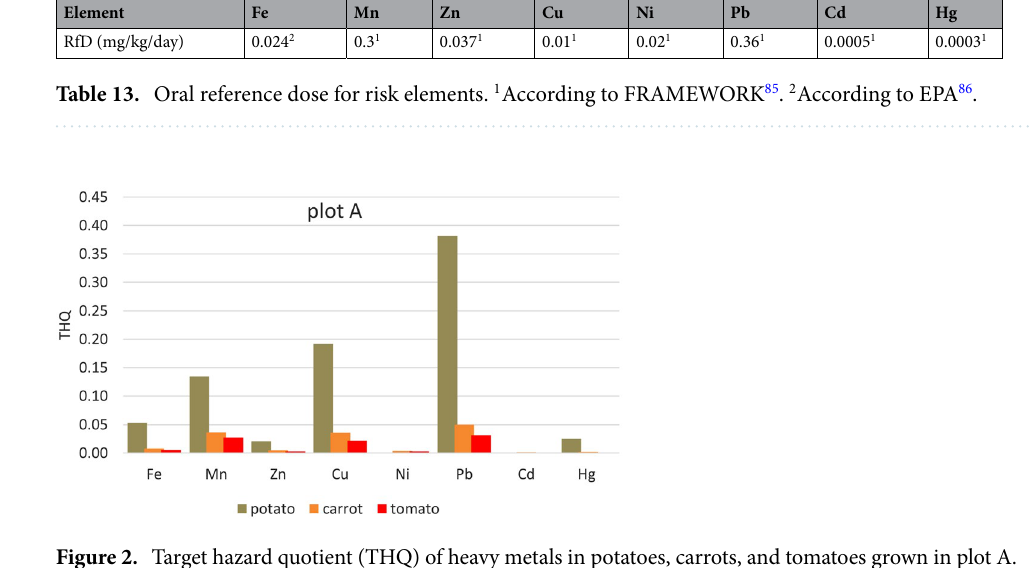
Figure 2. Target hazard quotient (THQ) of heavy metals in potatoes, carrots, and tomatoes grown in plot